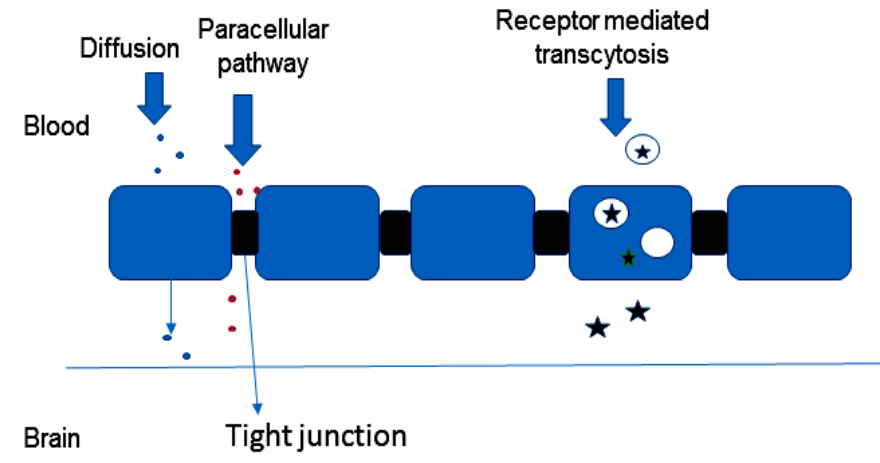
Figure 3. Pathway of therapeutics to the brain.